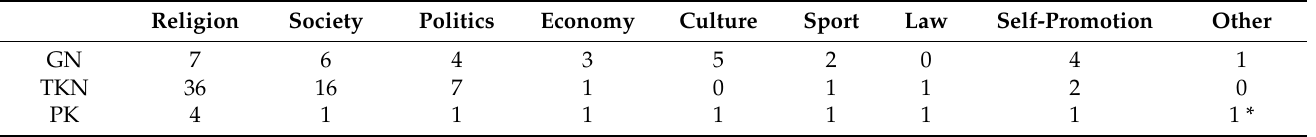
Table 11. Post topics (N =